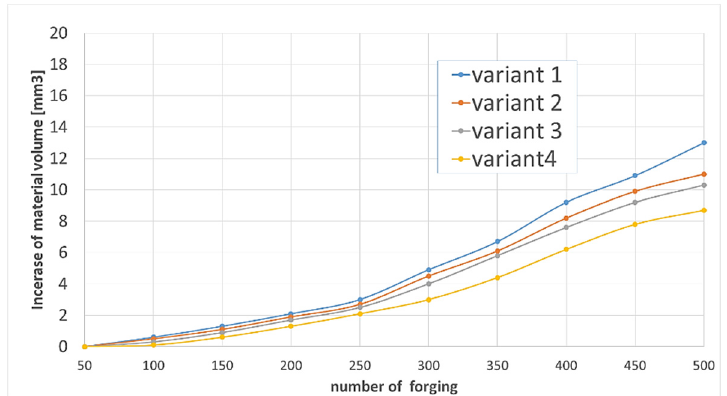
Figure 12. Scanning results of the cut dies for different pressure settings and solenoid valve open- ings.